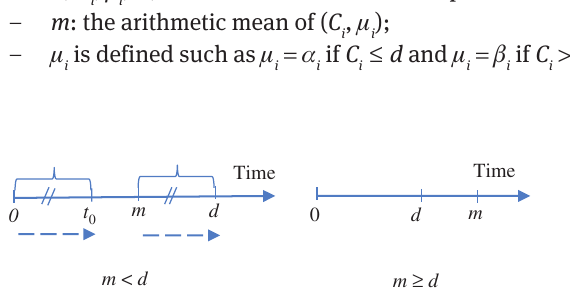
Figure 1: Possible Positions of d against m